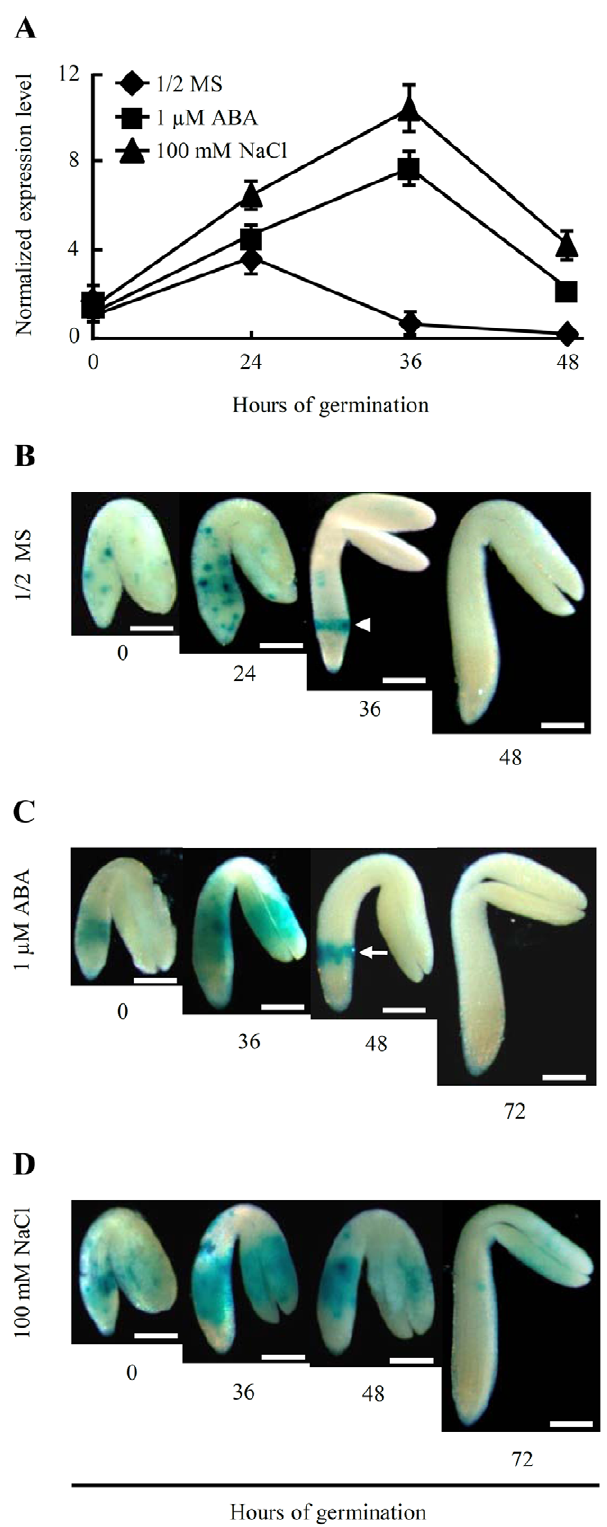
Figure 5. Temporal and spatial patterns of HRS1 expression during seed germination. (A) Comparisons of HRS1 expression levels at 0, 24, 36 and 48 HOG on 1/2 MS medium or those supplemented with 1 m M ABA or 100 mM NaCl by quantitative PCR. The amplification of ACT8 ( At1g49240 ) served as the internal control. The